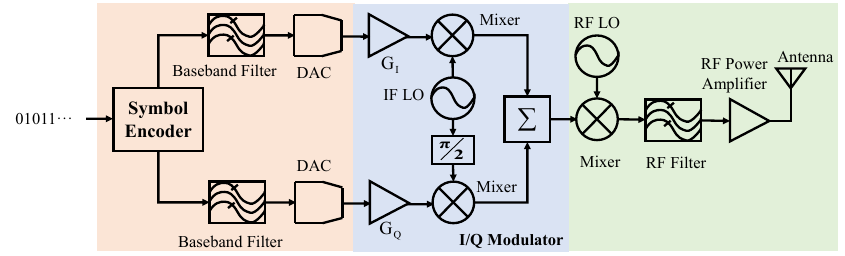
Figure 1. Structure of the typical